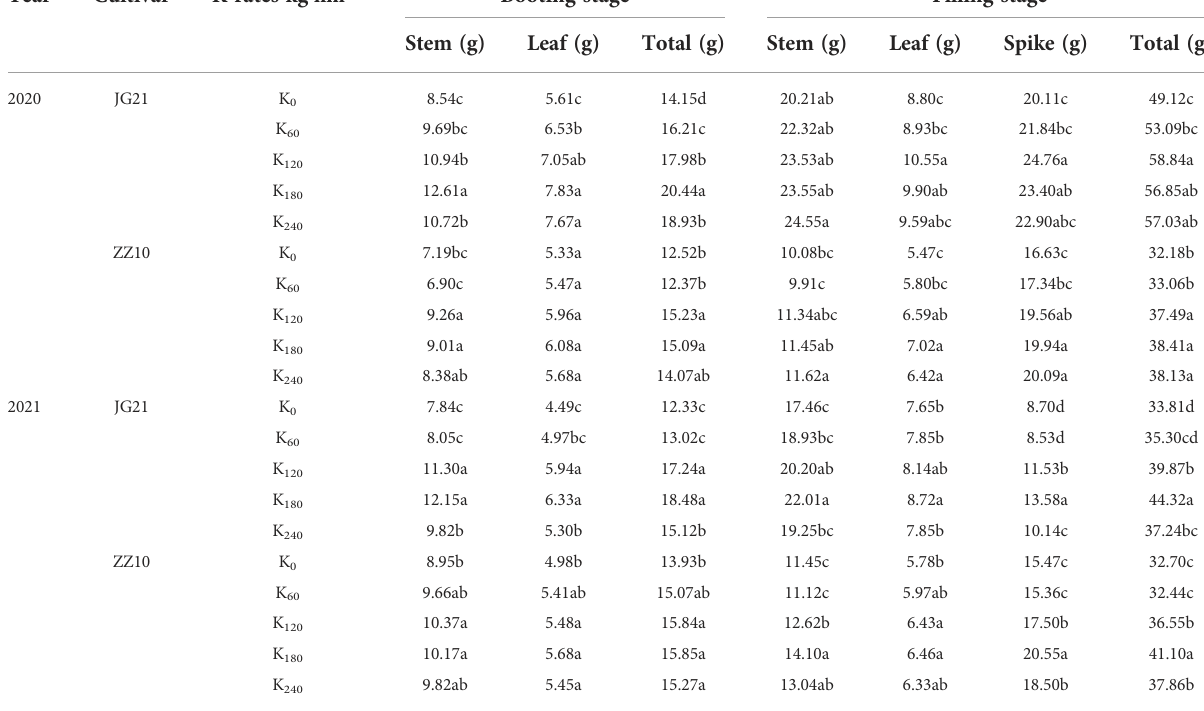
TABLE 3 Effect of potassium application on dry matter accumulation in foxtail millet shoot. Year Cultivar